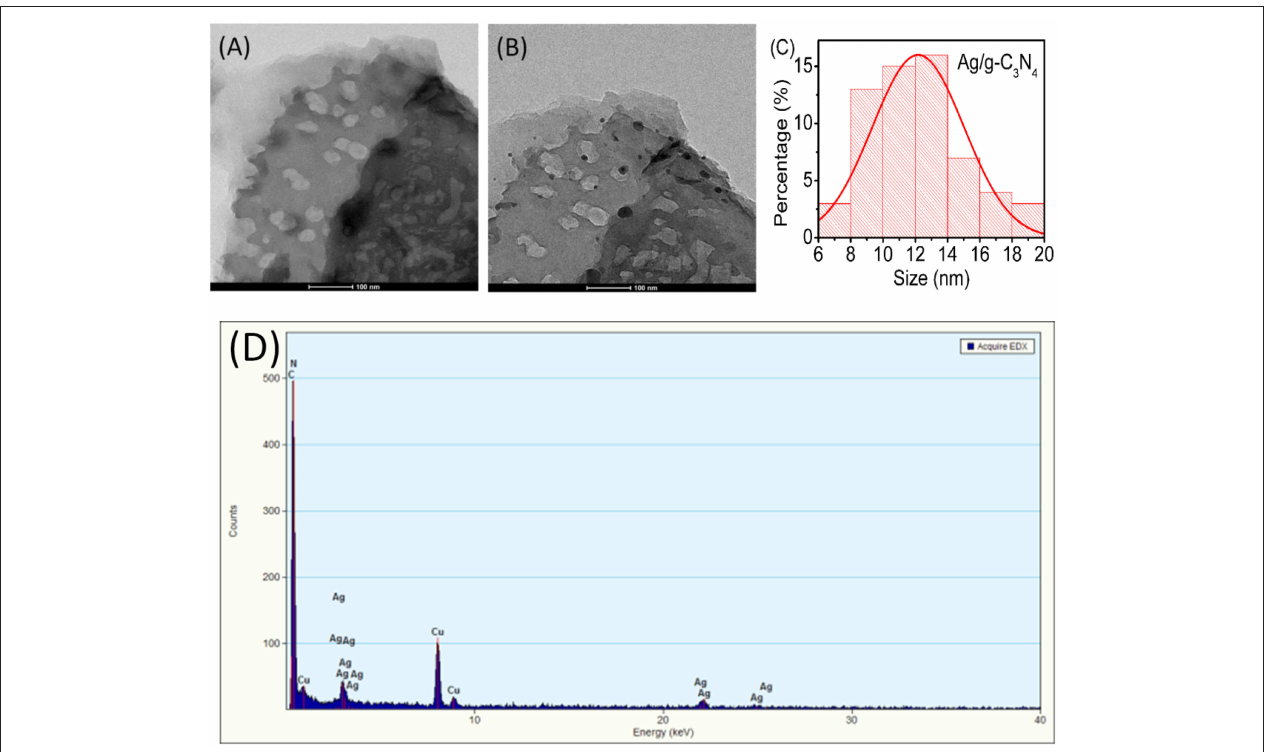
FIGURE 3 | TEM images of (A) pure g-C 3 N 4 and (B) 3%-Ag/g-C 3 N 4 . (C) size distribution of Ag NPs on 3%-Ag/g-C 3 N 4 . (D) EDX mapping of 3%-Ag/g-C 3 N 4 .